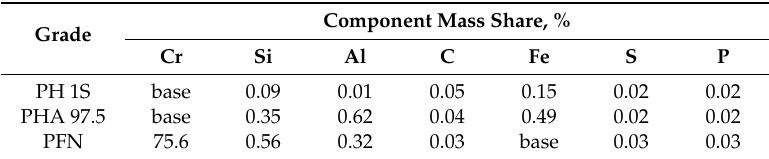
Table 1. Chromium and ferrochromium